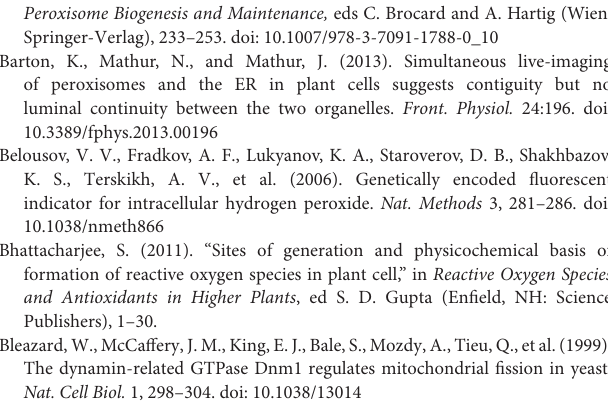
Figure S1 | A comparison of predominant mitochondrial size between dark grown plants of Arabidopsis thaliana ecotype Columbia “A” and the any1 mutant “B” expressing GFP targeted to mitochondria. Size bar applies for (A,B) = 5 µ m. Movie S1 | Time-lapse sequence taken over 2min of a portion of a cell from a low- light (60 µ mol m − 2 s − 1 ) grown double transgenic Arabidopsis seedling showing the general sub-cellular motility and lack of sustained association between chloroplasts (depicted in blue), mitochondria (green), and peroxisomes (yellow). Movie S2 | The close association of mitochondria (green), peroxisomes (yellow) and a single chloroplast in a cell exposed to HL for 4-min and then tracked over approximately 7.5min. Note that the association between the 3-peroxisomes on the plastid is maintained throughout while mitochondria appear to have relatively short but sustained contacts with the other two organelles. Movie S3 | A time-lapse sequence taken over nearly 5.5min shows mitochondria (green) and their strong but transient association with long peroxules (orange–yellow) extended from a chloroplast-attached peroxisome and an independent peroxisome (top left). Movie S4 | A time-lapse sequence taken over 6min of a cotyledon cell in the any1 mutant expressing a peroxisomal targeted YFP shows numerous peroxules being extended and retracted in response to HL exposure for 4-min. Movie S5 | Portion of a single cotyledon cell from a double transgenic any1 seedling exposed to HL for 4-min exhibits numerous chloroplasts (blue) surrounded by small, punctate mitochondria (green), and peroxisomes (orange–yellow) with the latter extending and retracting 8–15 µ m long peroxules. Movie S6 | Portion of a cell in an any1 plant double transgenic for YFP-PTS1-highlighted peroxisomes (yellow) and GFP-targeted mitochondria (green) observed over nearly 5min shows organelle association with a chloroplast (auto-fluorescent chlorophyll depicted in blue). A peroxisome becomes closely associated with the chloroplast after a 4-min HL treatment and repeatedly extends and retracts thin, tubular peroxules that interact transiently with mitochondria in their